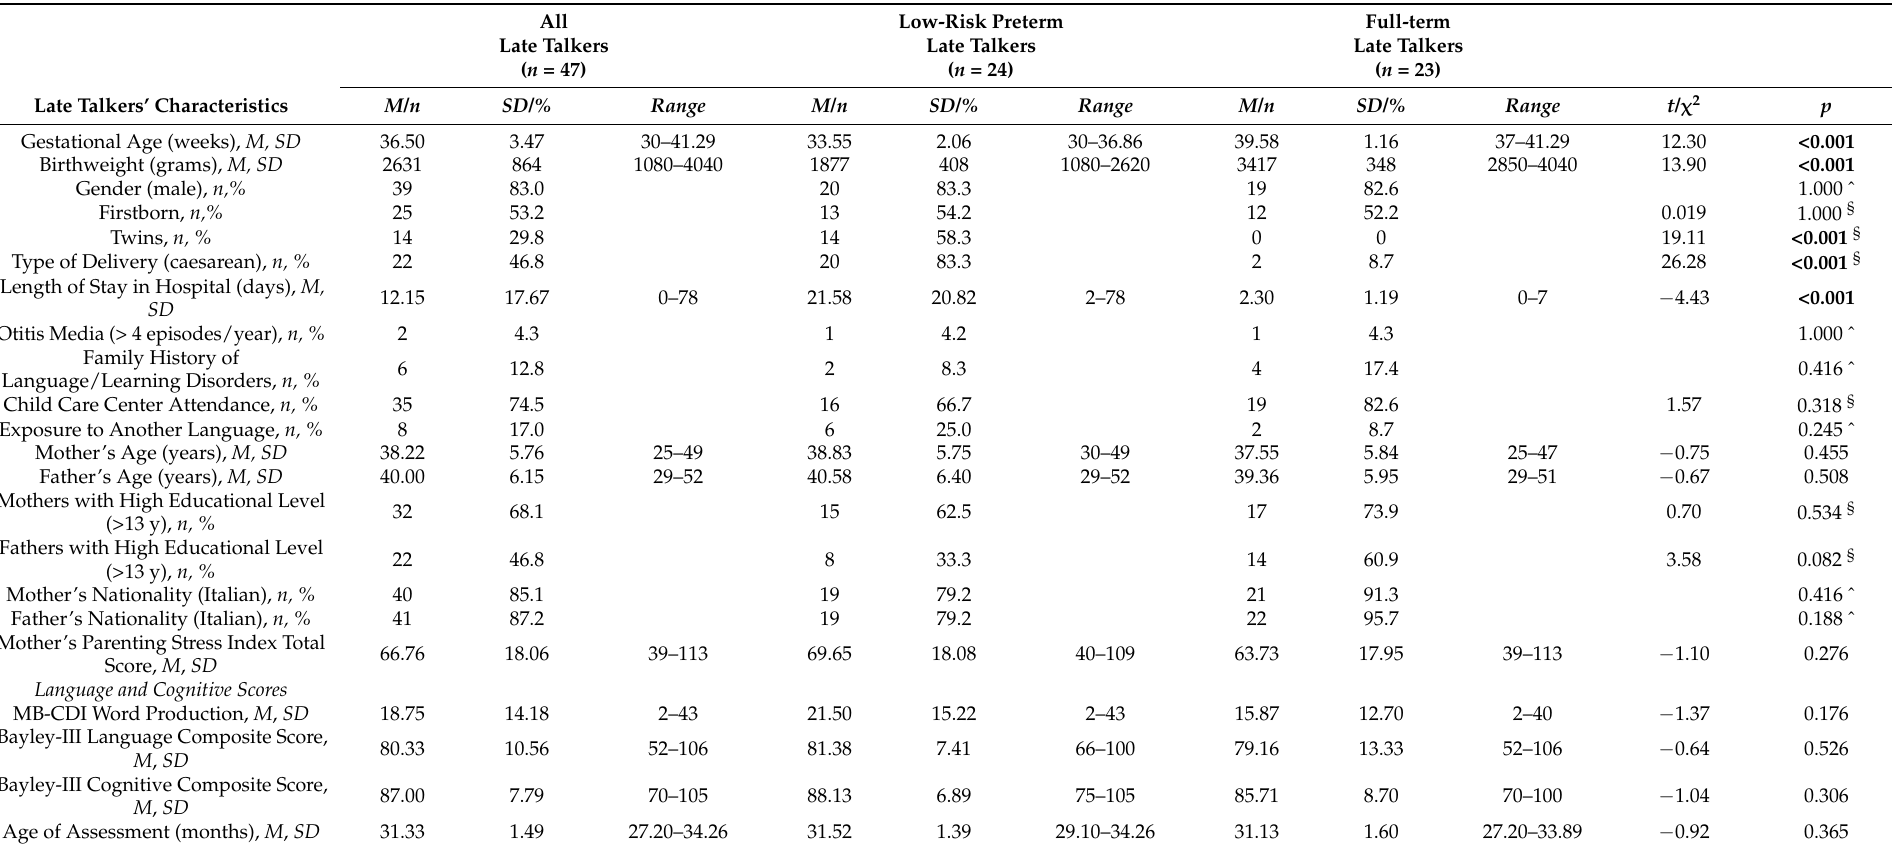
Table 1. Individual, Socio-demographic and Socio-Relational Characteristics, Language and Cognitive Scores of All, Low-Risk Preterm, and Full-Term Late